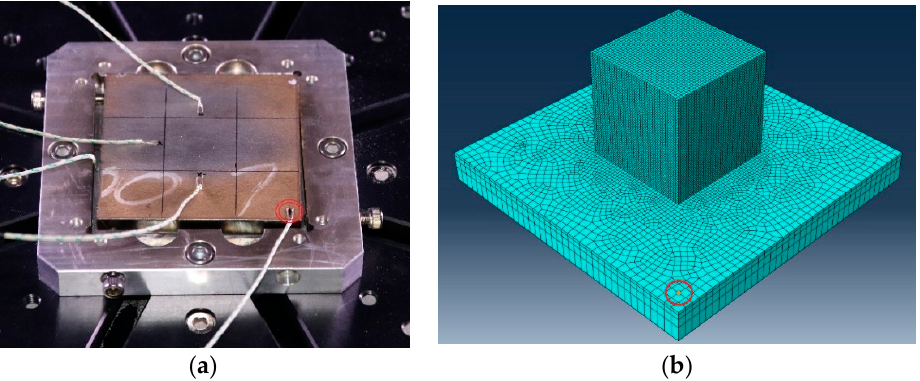
Figure 16. ( a ) Picture captured before the experiment illustrates the thermocouple position; ( b ) Meshed model marked with the nodal position.